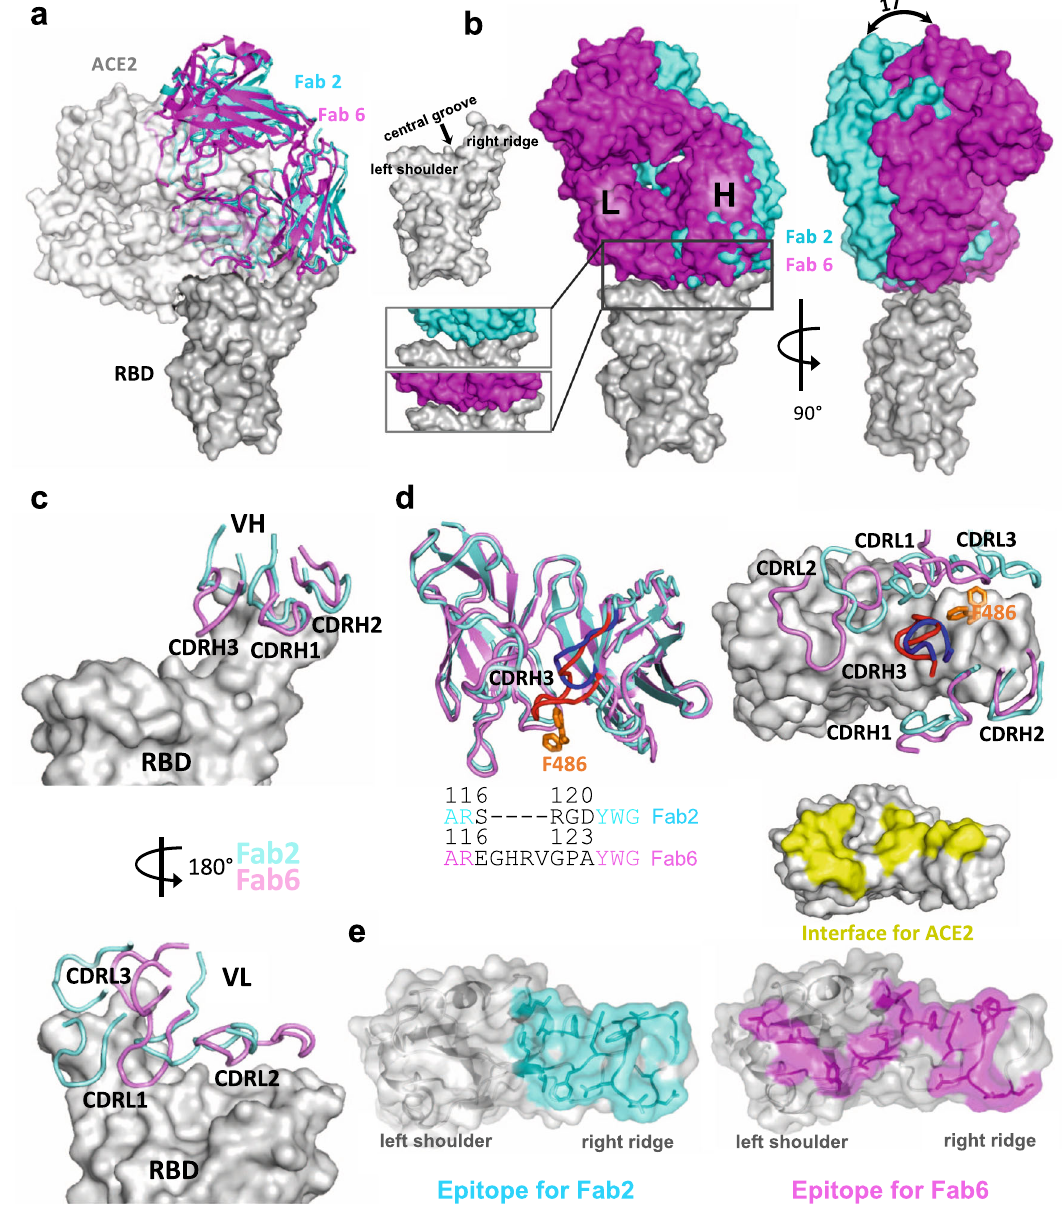
Fig. 3 Binding interfaces and epitopes of lead monoclonal antibodies. a Overlay of the structures of spike RBD from its complex with the host ACE2 receptor, Clone 2 or Clone 6 Fab indicates both antibody clones directly block the ACE2 access. b Overlay of the structures of spike RBD from its complex with Clone 2 or Clone 6 Fab reveals a 17° rotation pivoted at the right ridge of spike RBD, resulting in less contact of Clone 2 Fab light chain with the left shoulder of spike RBD. The comparison of the Clone 2 and Clone 6 Fab binding interfaces with spike RBD is shown in the bottom parallel insets. The nomenclature of the top surface of spike RBD is described in the top inset. c The orientations of the three CDRH (upper panel) and CDRL (lower panel) loops of Clone 2 or Clone 6 Fabs on spike RBD. The structures were overlaid with the RBD potions. d Left, overlay of Clone 2 and Clone 6 Fab molecules alone. The CDRH3 loops that have the largest conformational difference are highlighted in brighter colors (blue for clone 2 and red for clone 6). Lower inset, amino acid sequence alignment of the CDRH3 loops of both clones. Right, spike RBD residue F486, which is shown as orange sticks, has a large conformational change upon RBD-binding to the two clones. e Comparison of spike RBD epitope regions for Clone 2 and Clone 6 Fabs, highlighted in cyan and magenta, respectively. The spike binding interface for the hACE2 receptor is highlighted in